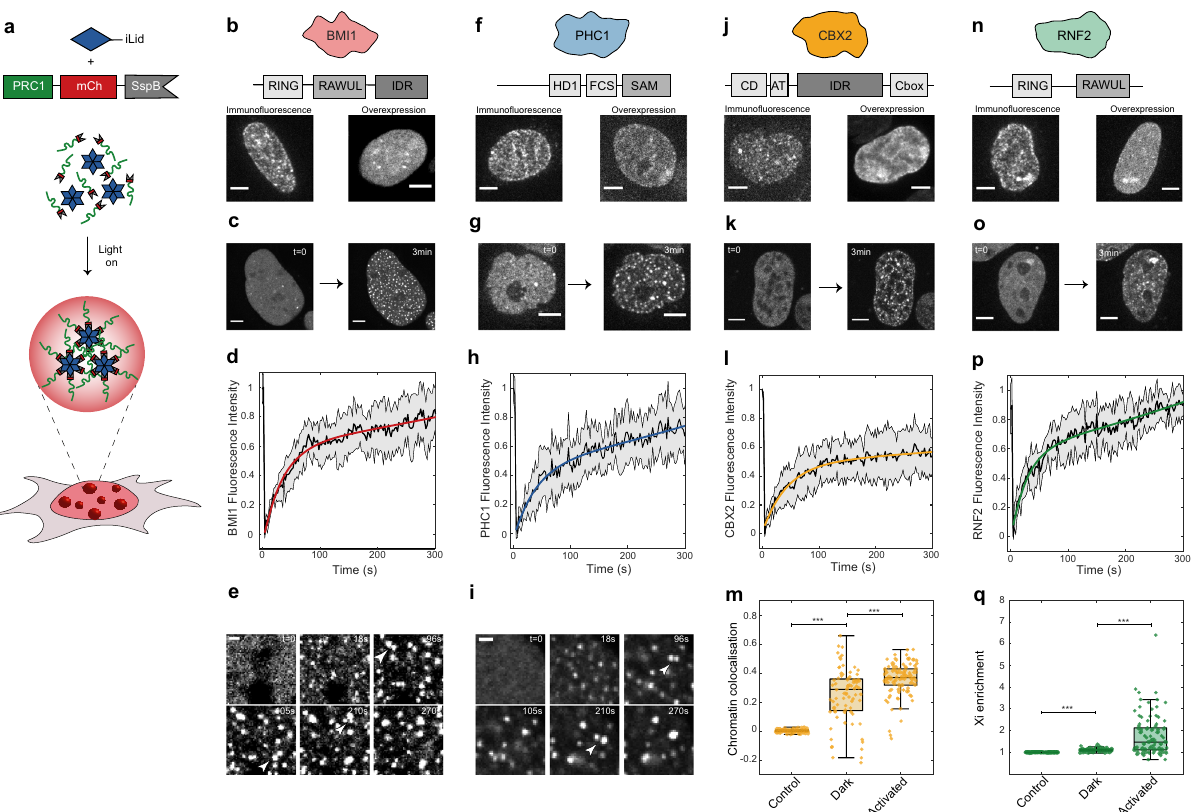
Fig. 1 PRC1 subunit oligomerization drives phase separation. a The Corelet system enables light-driven oligomerization to probe protein phase behaviour. b BMI1 visualization with immuno fl uorescence and overexpression. Scale bar is 5 µ m. c BMI1-mCh-sspB in HEK293 cells with NLS-Ferritin-Corelet before ( t = 0) and after blue light activation (3 min). Scale bar is 5 µ m. d FRAP recovery curve of BMI1-mCh-sspB Corelets. Data are presented as mean + / − SD, n = 5 cells. e BMI1 condensates fuse with one another. Arrows indicate condensates about to fuse. Scale bar is 1 µ m. f PHC1 visualization with immuno fl uorescence and overexpression. Scale bar is 5 µ m. g PHC1-mCh-sspB in HEK293 cells with NLS-Ferritin-Corelet before ( t = 0) and after blue light